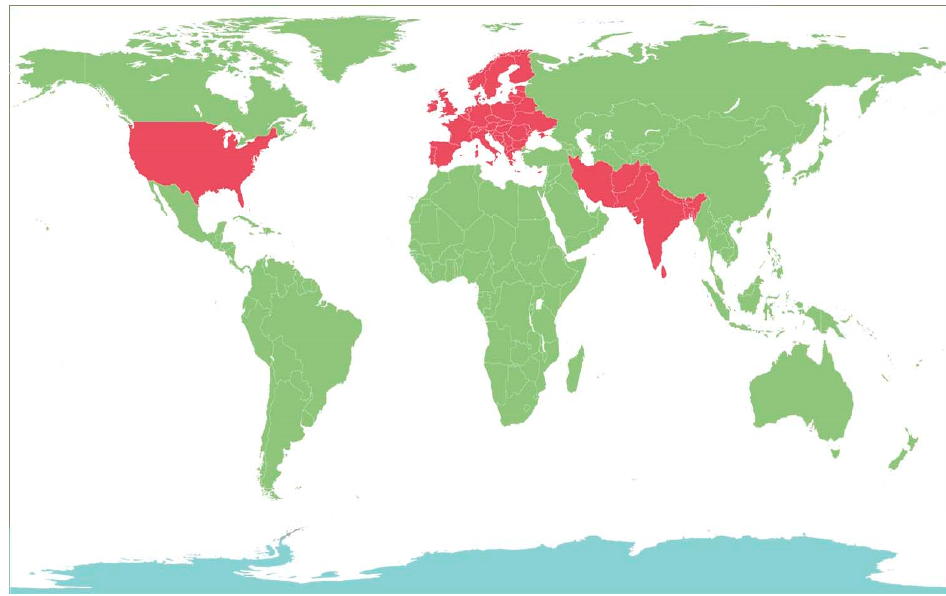
Figure 1. The areas where the Berberis plants are commonly grown (shown in red).